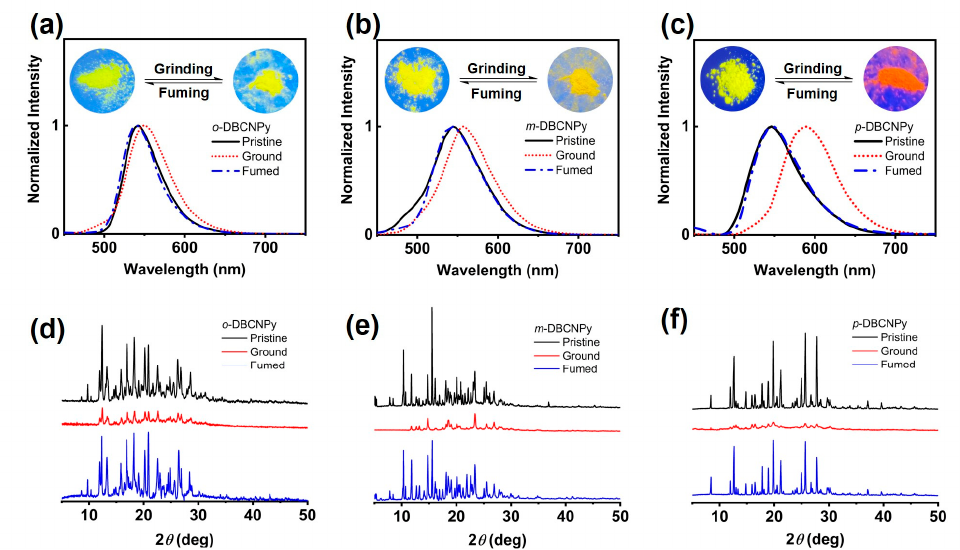
Figure 7. Fluorescence emission spectra and XRD patterns of o -DBCNPy ( a , d ), m -DBCNPy ( b , e ), and p -DBCNPy ( c , f ) when solid at various states (pristine, ground, and fumed); insets are images of the each solid under 365 nm UV light.